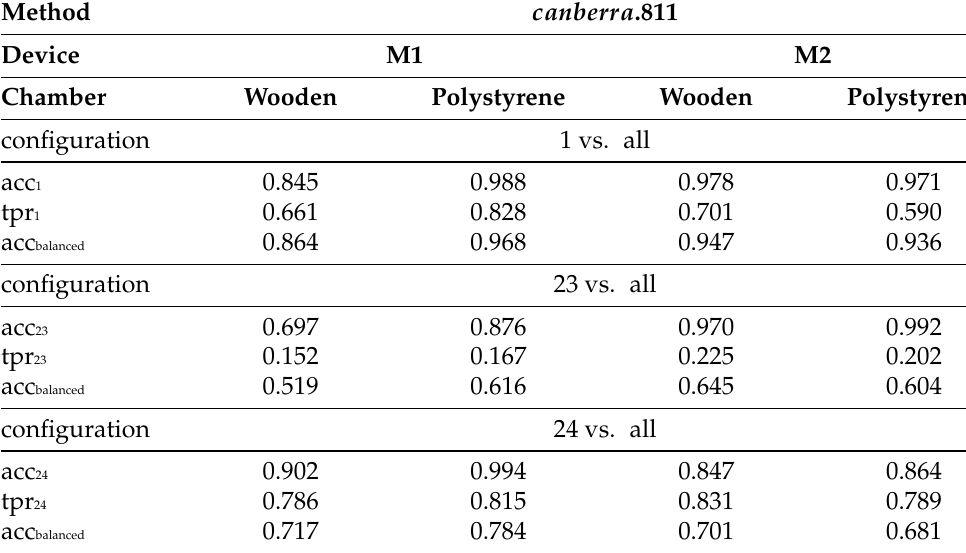
Table 8. The obtained acc class values in the 5 × MCCV-5 validation tests in the comparison of specified class vs. other classes for the test canberra .811 for devices M1 and